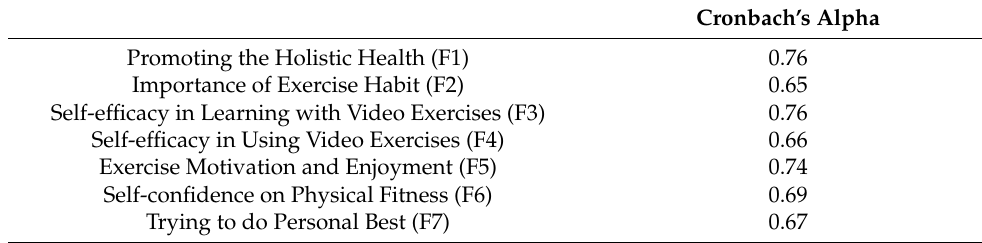
Table 2. Reliability Analysis of Chinese Version of the Attitudes toward Physical Activity Scale